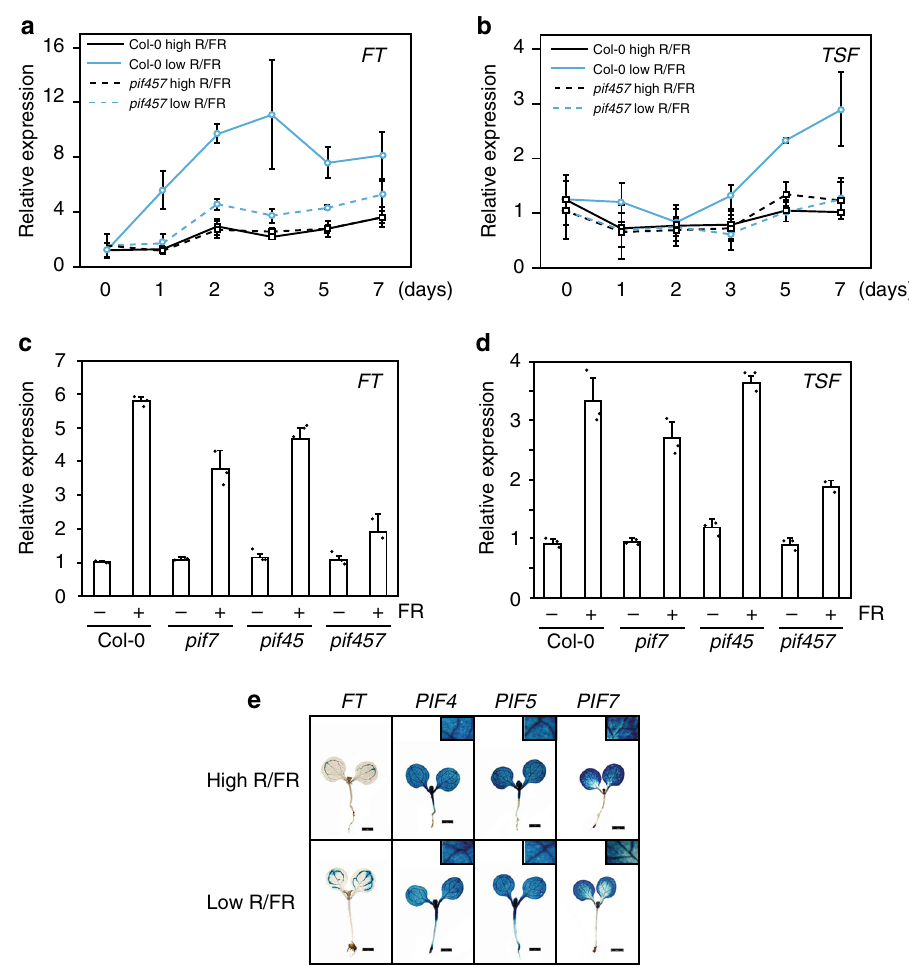
Fig. 2 PHYTOCHROME-INTERACTING FACTORS ( PIF ) proteins mediate FLOWERING LOCUS ( FT ) and TWIN SISTER of FT ( TFS ) expression in the low red/far- red (R/FR). a , b FT and TSF messenger RNA (mRNA) level using quantitative real-time PCR (RT-qPCR) after shift from high to low R/FR in Col-0 and pif4 pif5 pif7 . Plants were de-etiolated for 5 days under long days (LDs) at 22 °C in high R/FR and samples were harvested at zeitgeber (ZT) 15 – 6 before 0 and 1, 2, 3, 5, and 7 days after transfer to low R/FR. Error bars represent 2× SEM. c , d FT and TSF mRNA levels of plants growing under LDs at 22 °C in high and low R/FR. Plants were grown for 5 days in high R/FR for complete de-etiolation. On day 6, plants were either shifted to low R/FR (FR + ) or kept in high R/ FR (FR − ). Samples were harvested 10 days after sowing at ZT 15 – 16. Error bars represent standard deviation of three biological and three technical replicates, individual data points are indicated with black dots. e β -Glucuronidase (GUS) staining of pPIF4::GUS , pPIF5::GUS , and pPIF7::GUS transgenic seedlings 7 days after sowing. Plants were grown on soil for 5 days under LDs at 22 °C in high R/FR and either kept in the same condition of shifted to low R/FR on day 6. Samples were harvested after GUS staining at ZT 15 – 16. Scale bar corresponds to 1